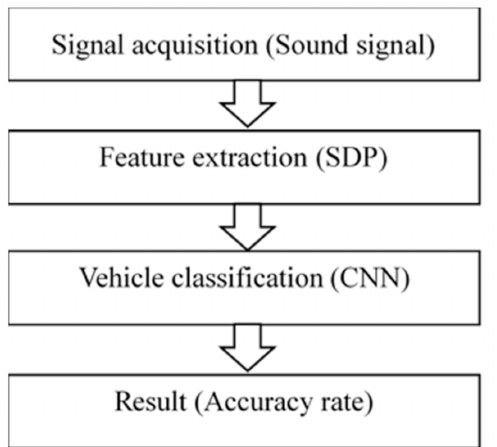
Figure 5. Vehicle identification flow chart.